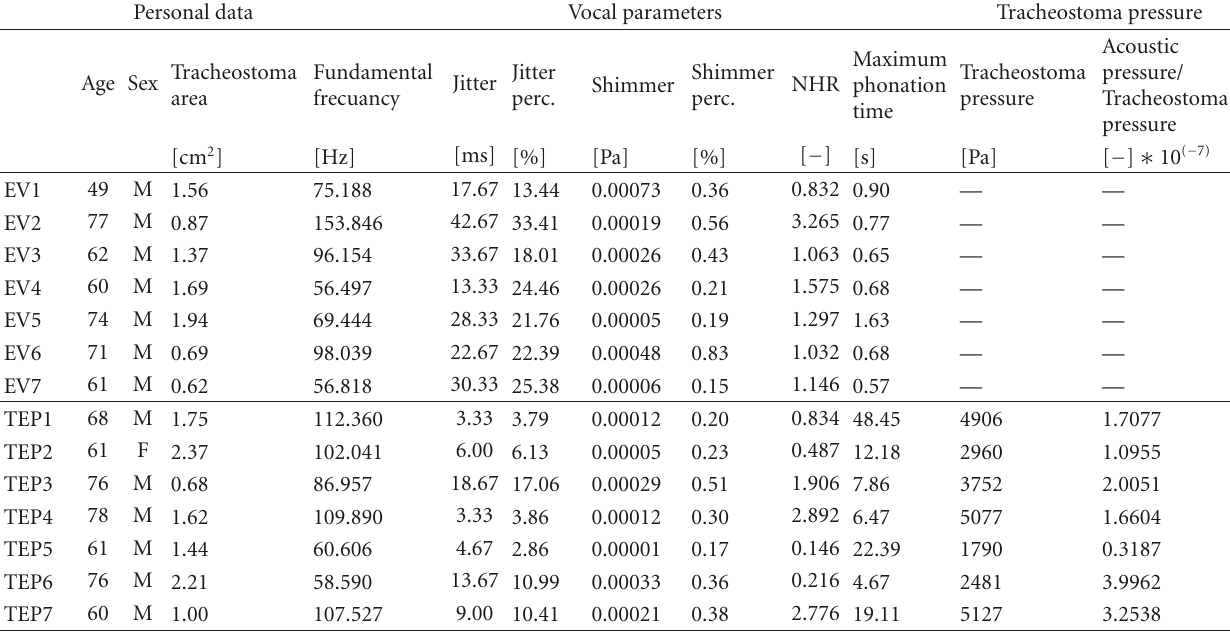
Table 1: Patient data, vocal, and pressure